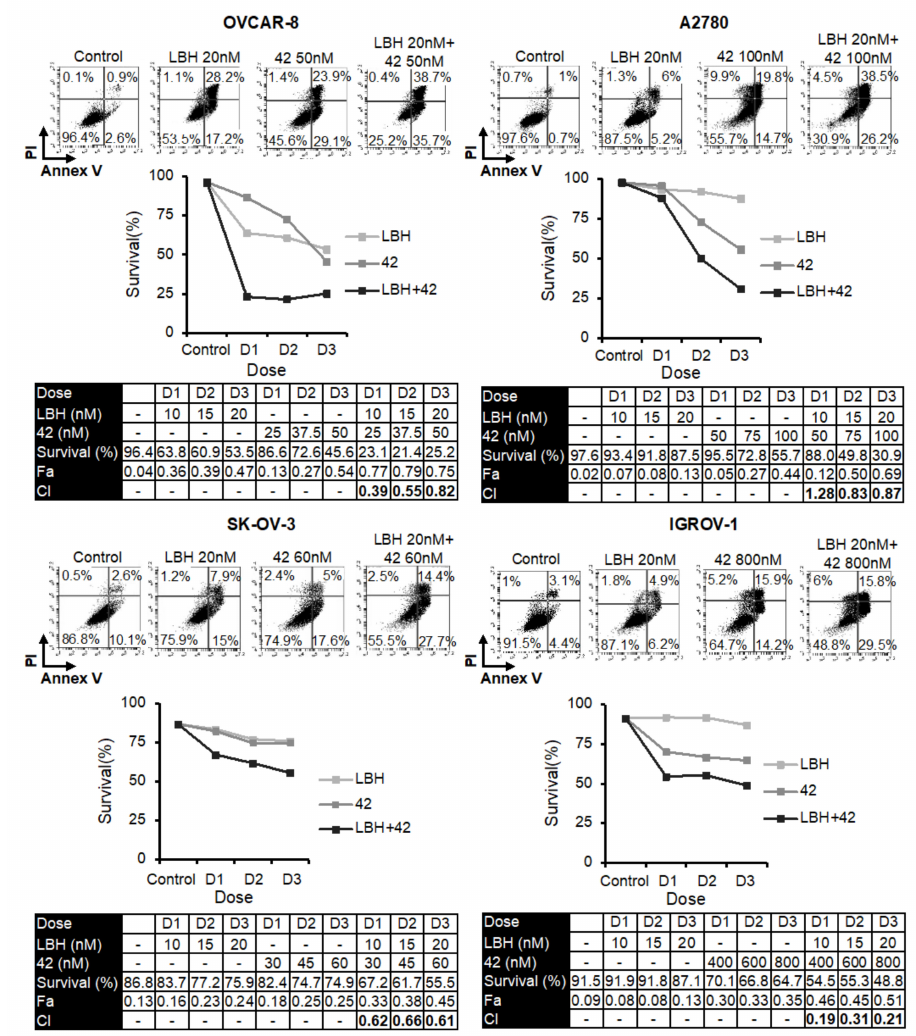
Figure 2. Synergistic effect of LBH and 42 in OCCLs. Cells were exposed for 72 h to the indicated concentrations of LBH and 42 at a constant ratio or vehicle control, and the percentage of apoptotic cells was assessed by flow cytometry (after cell staining with annexin V and propidium iodide). CI values, calculated using Compusyn Software, are